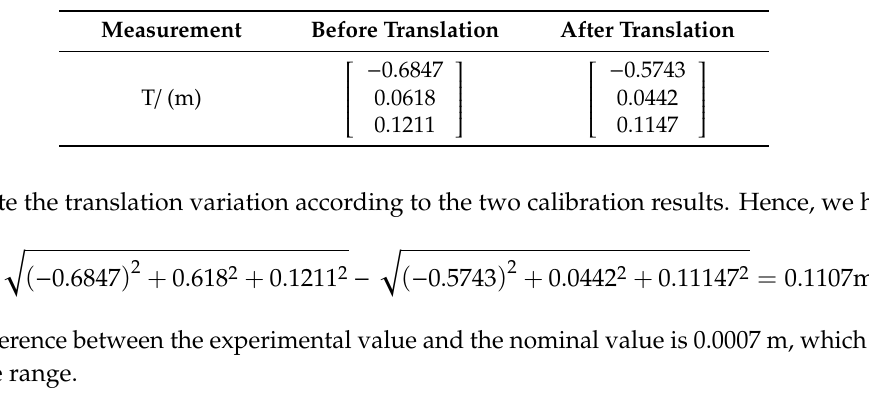
Table 2. Translation incremental verification results.